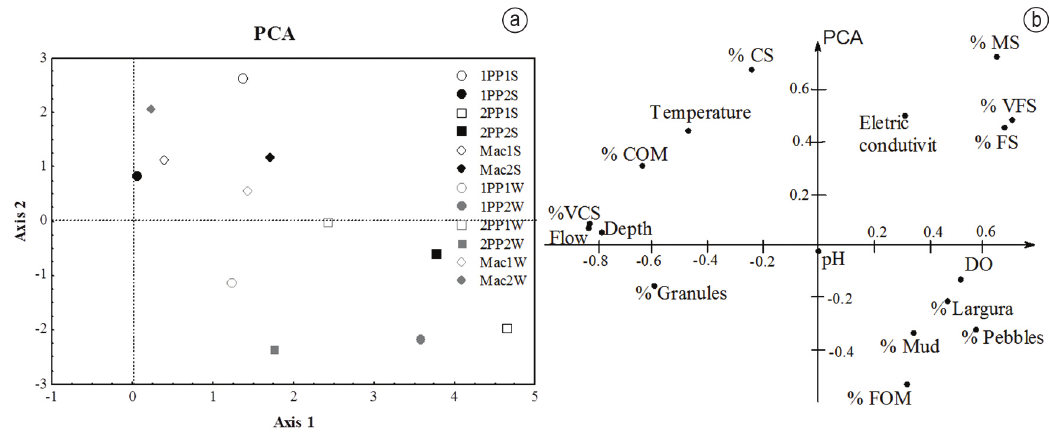
Figure 2. Scores ordination of the PC 1 and 2 of PCA for the sampled streams (a) and the vectors of the variables physical, chemical and of grain texture with the score of the PC 1 and 2 of PCA (b). 1PP1S: stream 1 of Poço Preto site 1, Summer; 1PP2S: stream 1 of Poço Preto site 2, Summer; 2PP1S: stream 2 of Poço Preto site 1, Summer; 2PP2S: stream 2 of Poço Preto site 2, Summer; Mac1S: stream of Macuco site 1, Summer; Mac2S: stream of Macuco site 2, Summer; 1PP1W: stream 1 of Poço Preto site 1, Winter; 1PP2W: stream 1 of Poço Preto site 2, Winter; site 2; 2PP1W: stream 2 of Poço Preto site 1, Winter; 2PP2W: stream 2 of Poço Preto site 2, Winter; Mac1W: stream of Macuco site 1, Winter; Mac2W: stream of Macuco site 2, Winter; VFS = very fine sand; FS = fine sand; MS =